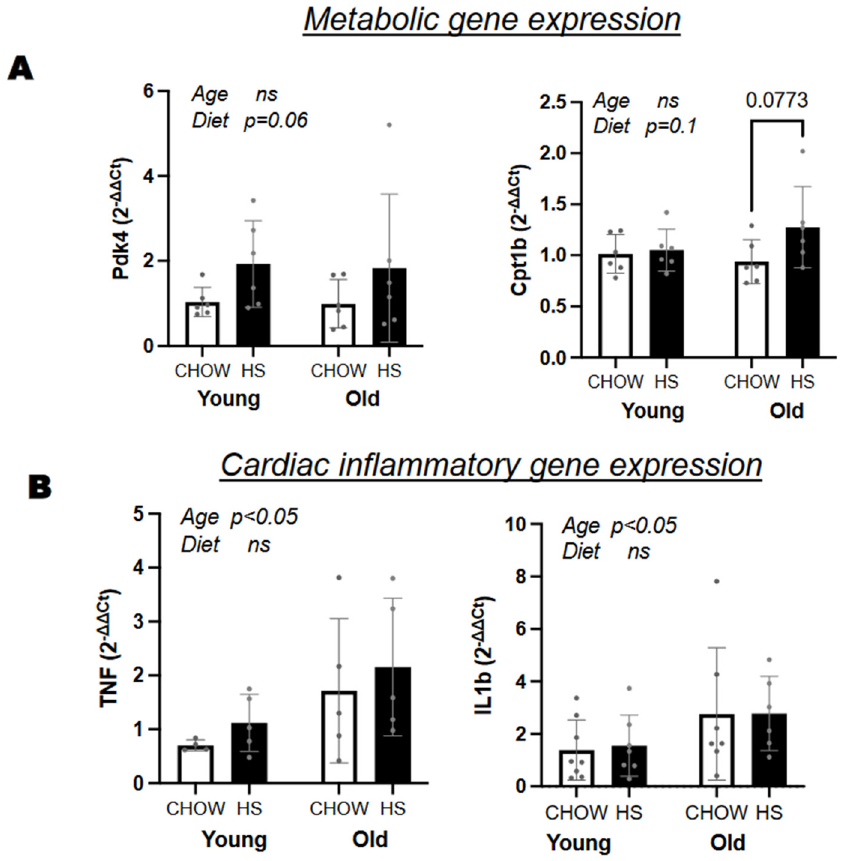
Figure 5. Gene expression and histology of heart tissue. ( A ) Differences in metabolic and ( B ) inflammatory genes between diet and age groups; ( B ). Age and diet effects are indicated with “ns” if above 0.1, with p -value if between 0.05–0.1, and significant if below 0.05. Data expressed as mean ± SD.